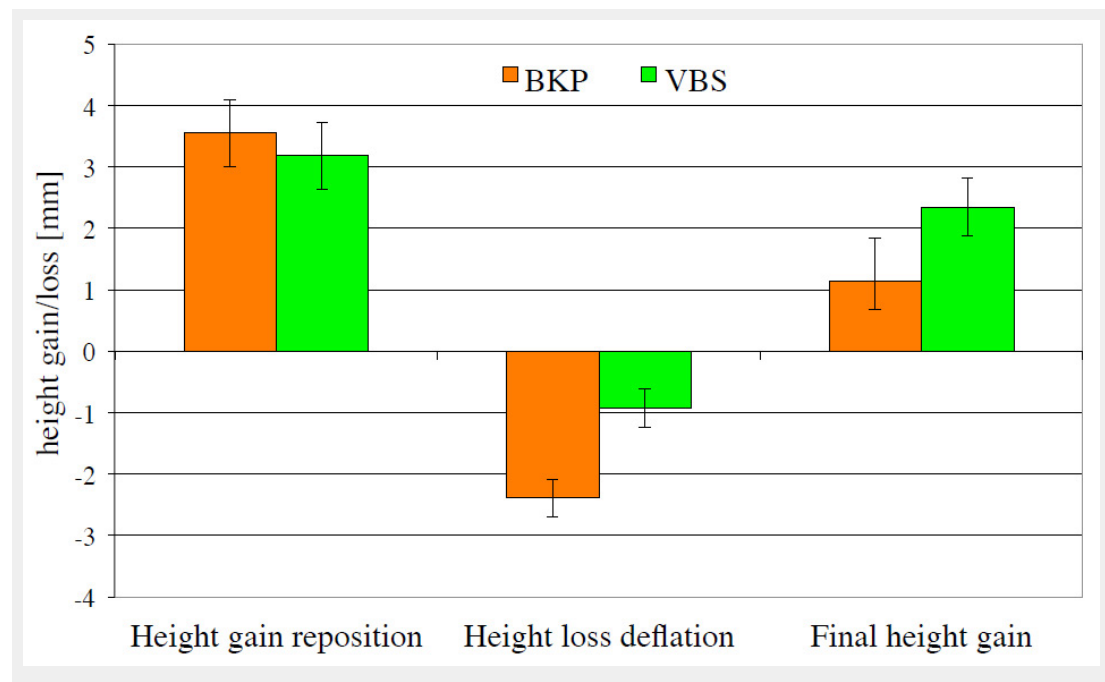
The potential of height restoration and maintenance has been assessed in vitro on cadaver specimens. 24 vertebral bodies were fractured and kept under a preload of 110 N in order to maintain the “physiological” pressure. Then the height was restored using either ballon kyphoplasty (BKP) or vertebral body stenting (VBS). With the stent the relapse after deflation of the balloon is significantly lower which in turn leads to better height restoration in